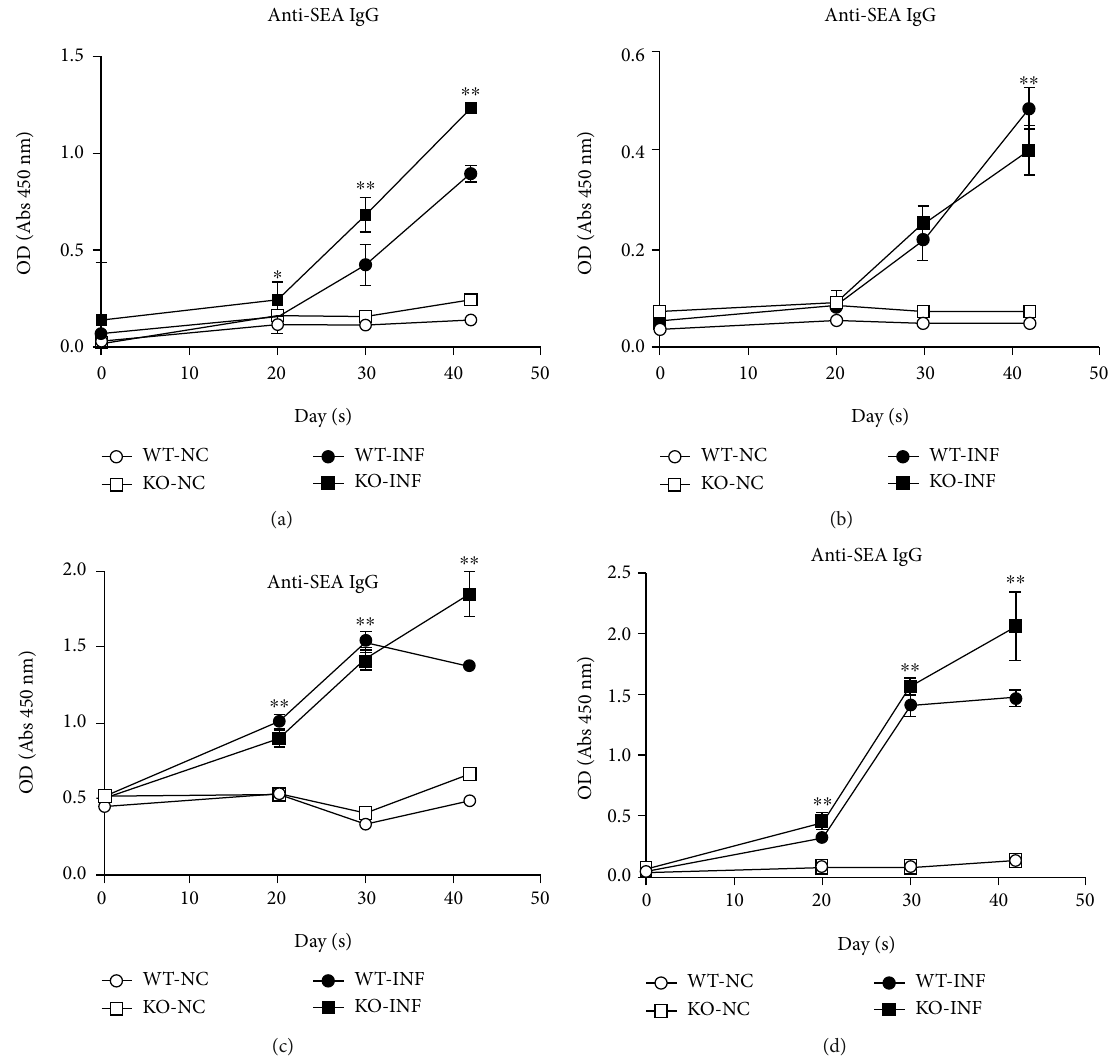
Figure 6: Speci fi c antibody responses in USP21 fl / fl FOXP3 Cre mice infected with S. japonicum . (a – d) Serum collected from the WT and KO mice in the NC and INF groups ( n = 26 ± 2 /group) at di ff erent stages of the infection (uninfected, day 20, day 30, day 42). (a) Comparison of the changes in the anti-SEA IgG content. The data are presented as the means ± SD . For the comparison between infection groups, ∗ p = 0 : 01 on day 20, ∗∗ p < 0 : 001 on day 30, and ∗∗ p < 0 : 001 on day 42. (b) Comparison of the anti-SEA IgM content. The data are presented as the means ± SD , and ∗∗ p = 0 : 002 on day 42 when comparing between the infection groups. (c) Comparison of the anti-SWAP IgG contents. The data are presented as the means ± SD ; for the comparison between infection groups, ∗∗ p < 0 : 001 on day 20, ∗∗ p = 0 : 003 on day 30, and ∗∗ p < 0 : 001 on day 42. (d) Comparison of the anti-SWAP IgM contents. The data are presented as the means ± SD . For the comparison between infection groups, ∗∗ p < 0 : 001 on day 20, ∗∗ p = 0 : 004 on day 30, and ∗∗ p < 0 : 001 on day